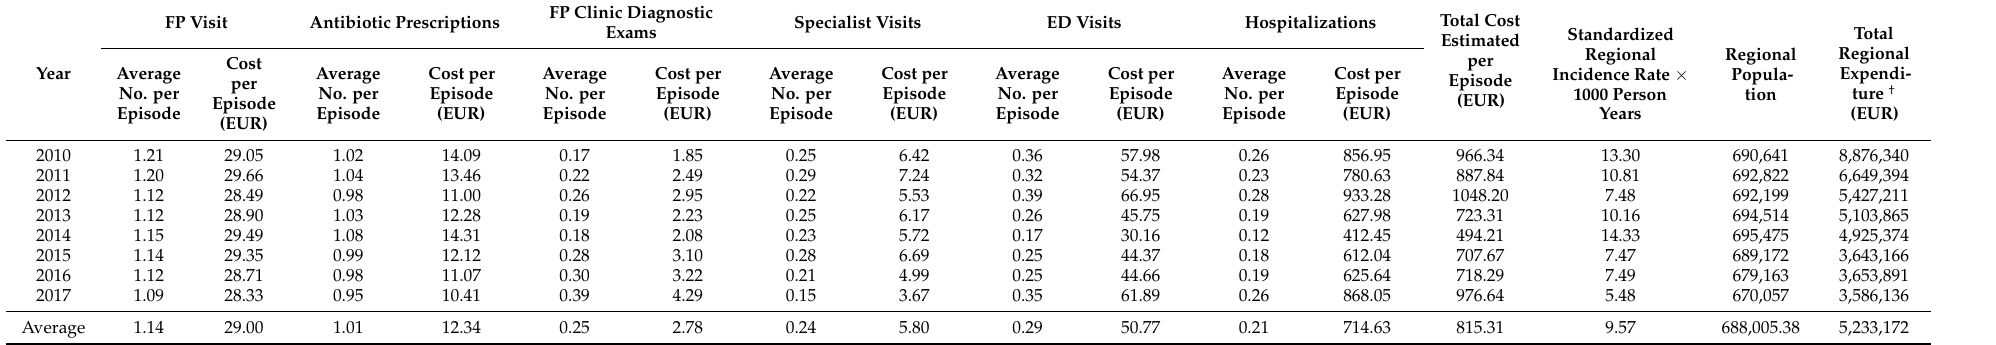
Table 5. Pneumonia HCRU and related costs ( N = 3926, Pedianet 2010–2017).